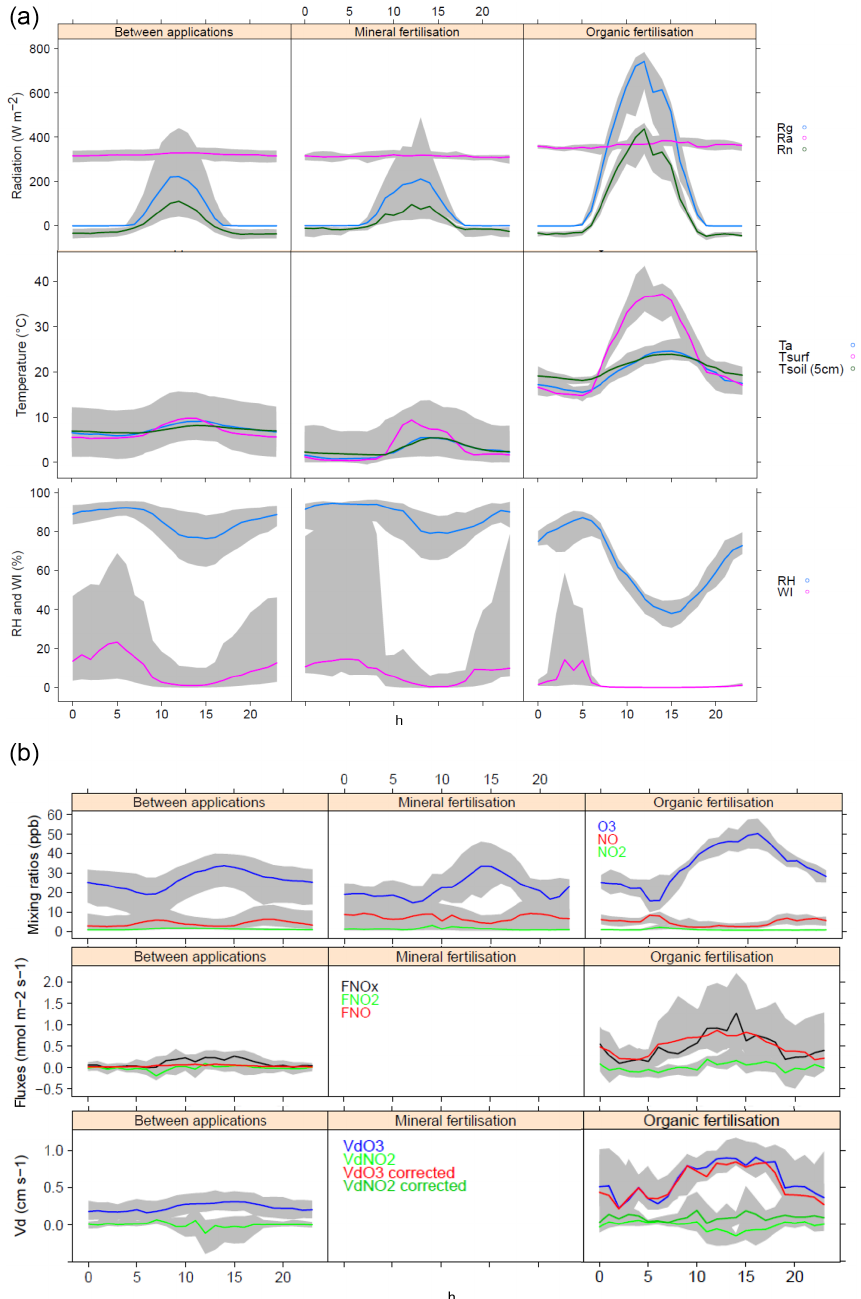
Figure 7. (a) Diurnal cycles of global irradiance and net radiation, air and soil temperatures, relative humidity and wetness index averaged over the three periods of interest at the Grignon field site. The shaded areas represent the interquartile range. (b) Diurnal cycles of NO, NO 2 and O 3 mixing ratios and fluxes as well as the deposition velocities of NO 2 and O 3 , averaged over the three periods of interest at the Grignon field site. The shaded areas represent the interquartile range. The deposition velocity of NO 2 and O 3 based on the fluxes accounting for chemical reactions above ground are also shown ( V dO and V dNO 3 2